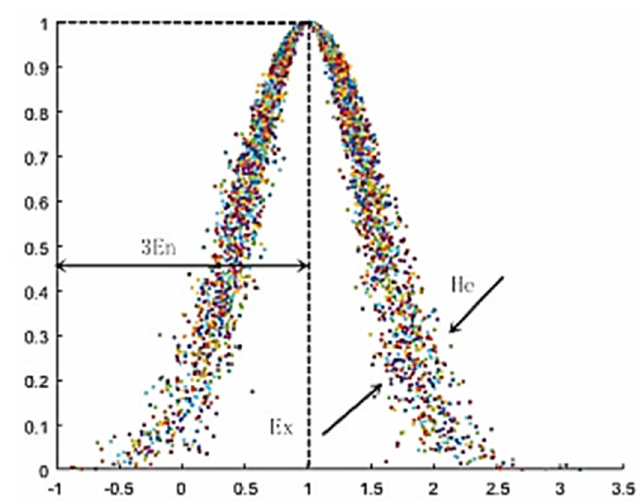
Figure 4. Cloud model digital feature